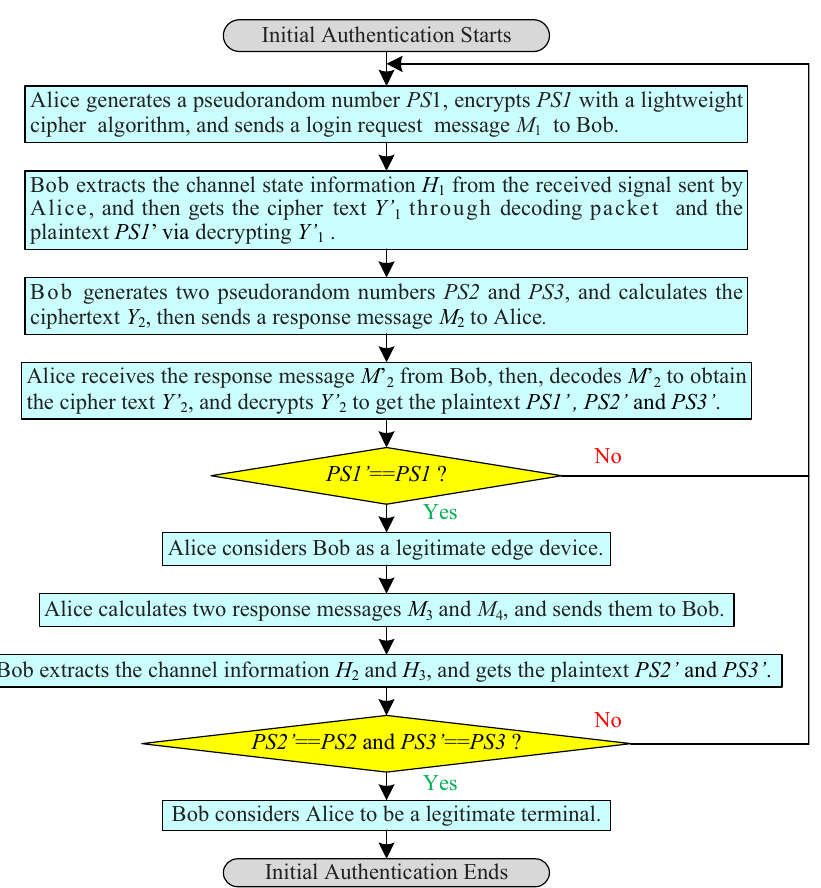
Figure 3. Process flowchart of initial